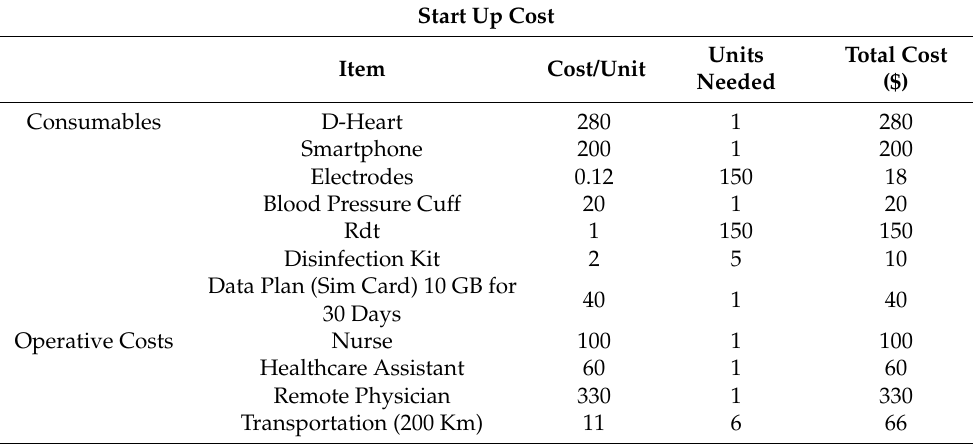
Table 4. RDT and ECG screening model for 150 Individuals for a 6-day screening.